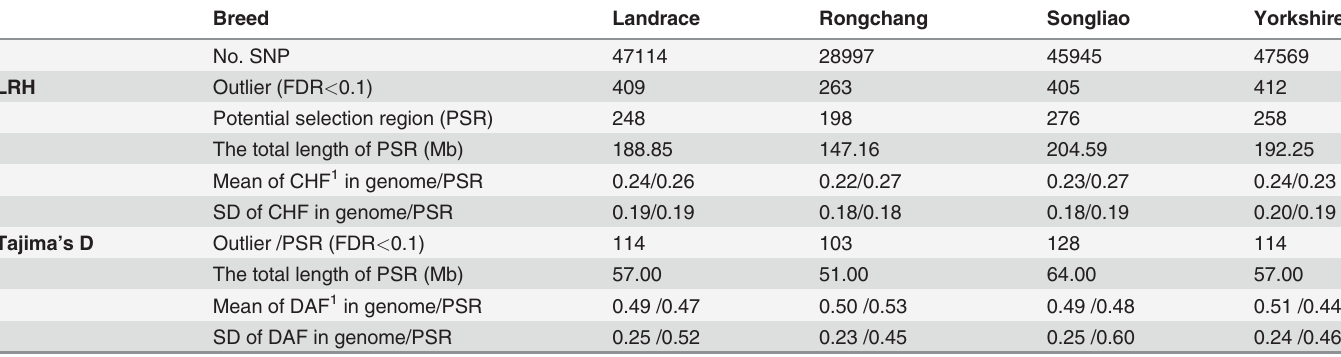
Table 1. Summary of selection signatures detected by LRH and Tajima ’ s D in four pig breeds.